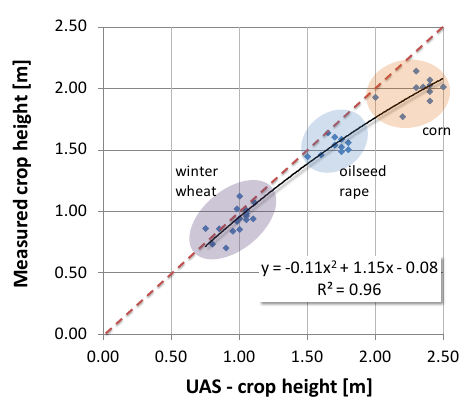
Figure 9. Measured crop height vs. UAS crop height (max